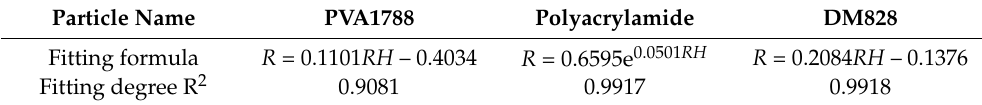
Figure 6. Effect of rolling resistance coefficient on average porosity and total filtration resistance of filter cake. Table 2. Relationship between the equilibrium moisture regain and relative humidity of particles.